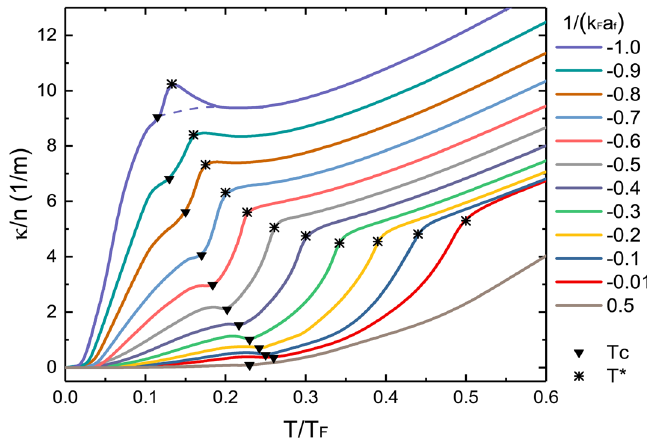
Figure 1. Thermal conductivity κ of an ultracold Fermi gas, normalized by n and in units of 1/ m , as a function 1 of T / T F for different ν = ( k F a f ) − . The asterisks and triangles mark the specific thermal conductivities at T ∗ and T c , respectively. The dashed line is a possible estimate when T ∗ is not clearly defined (see